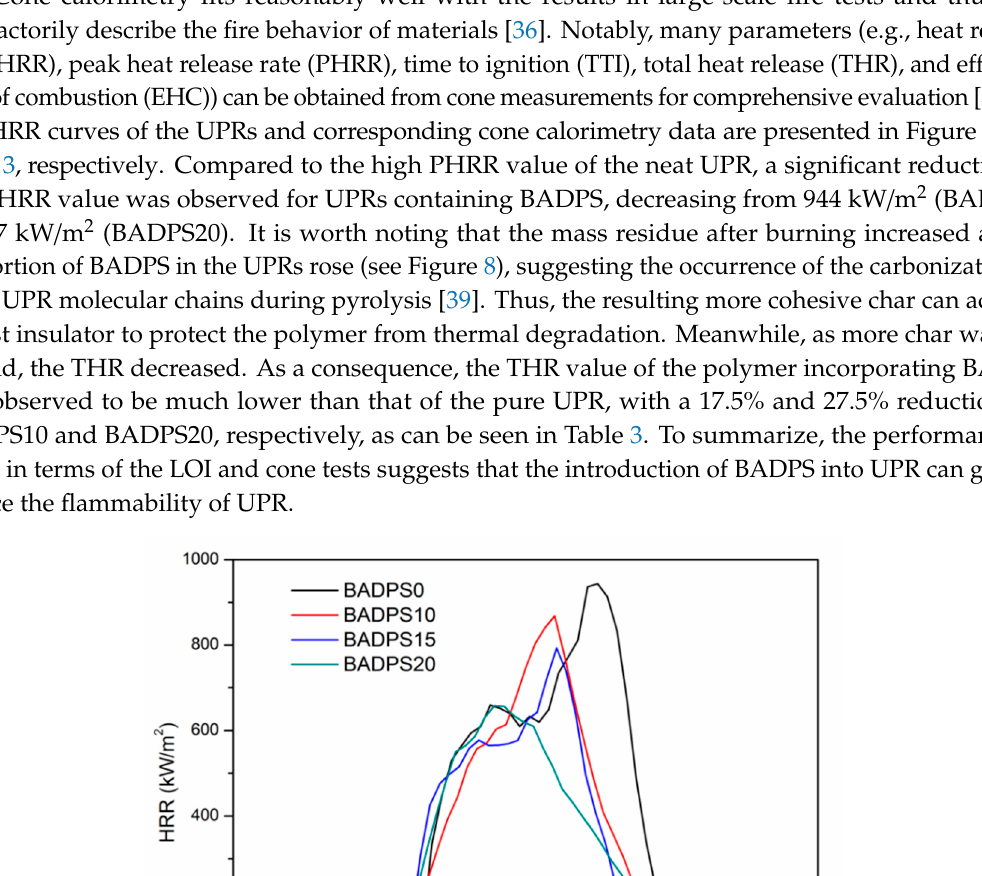
Table 3. Cone calorimetry data for the different UPRs.